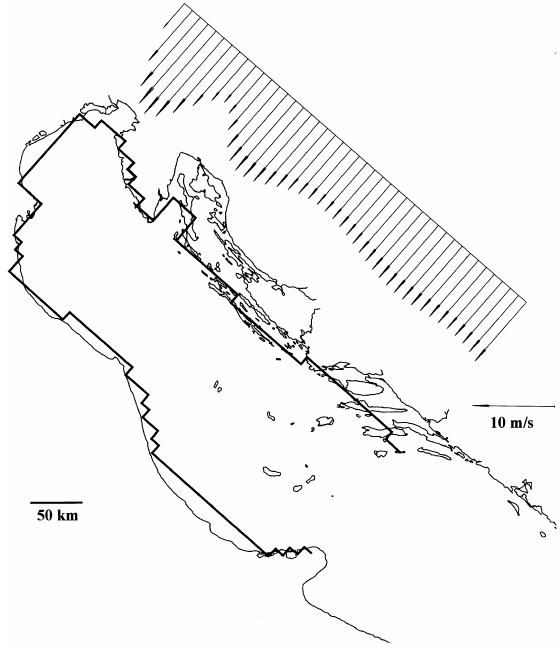
Fig. 2. Domain of the oceanographic model and the bora wind pro- file used in the numerical